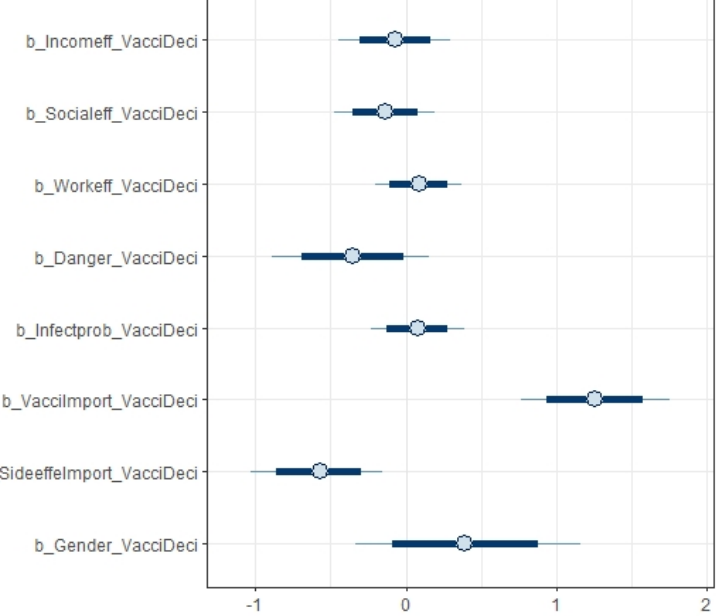
Figure 7. Distribution of the coefficients of factors influencing decisions on vaccination.